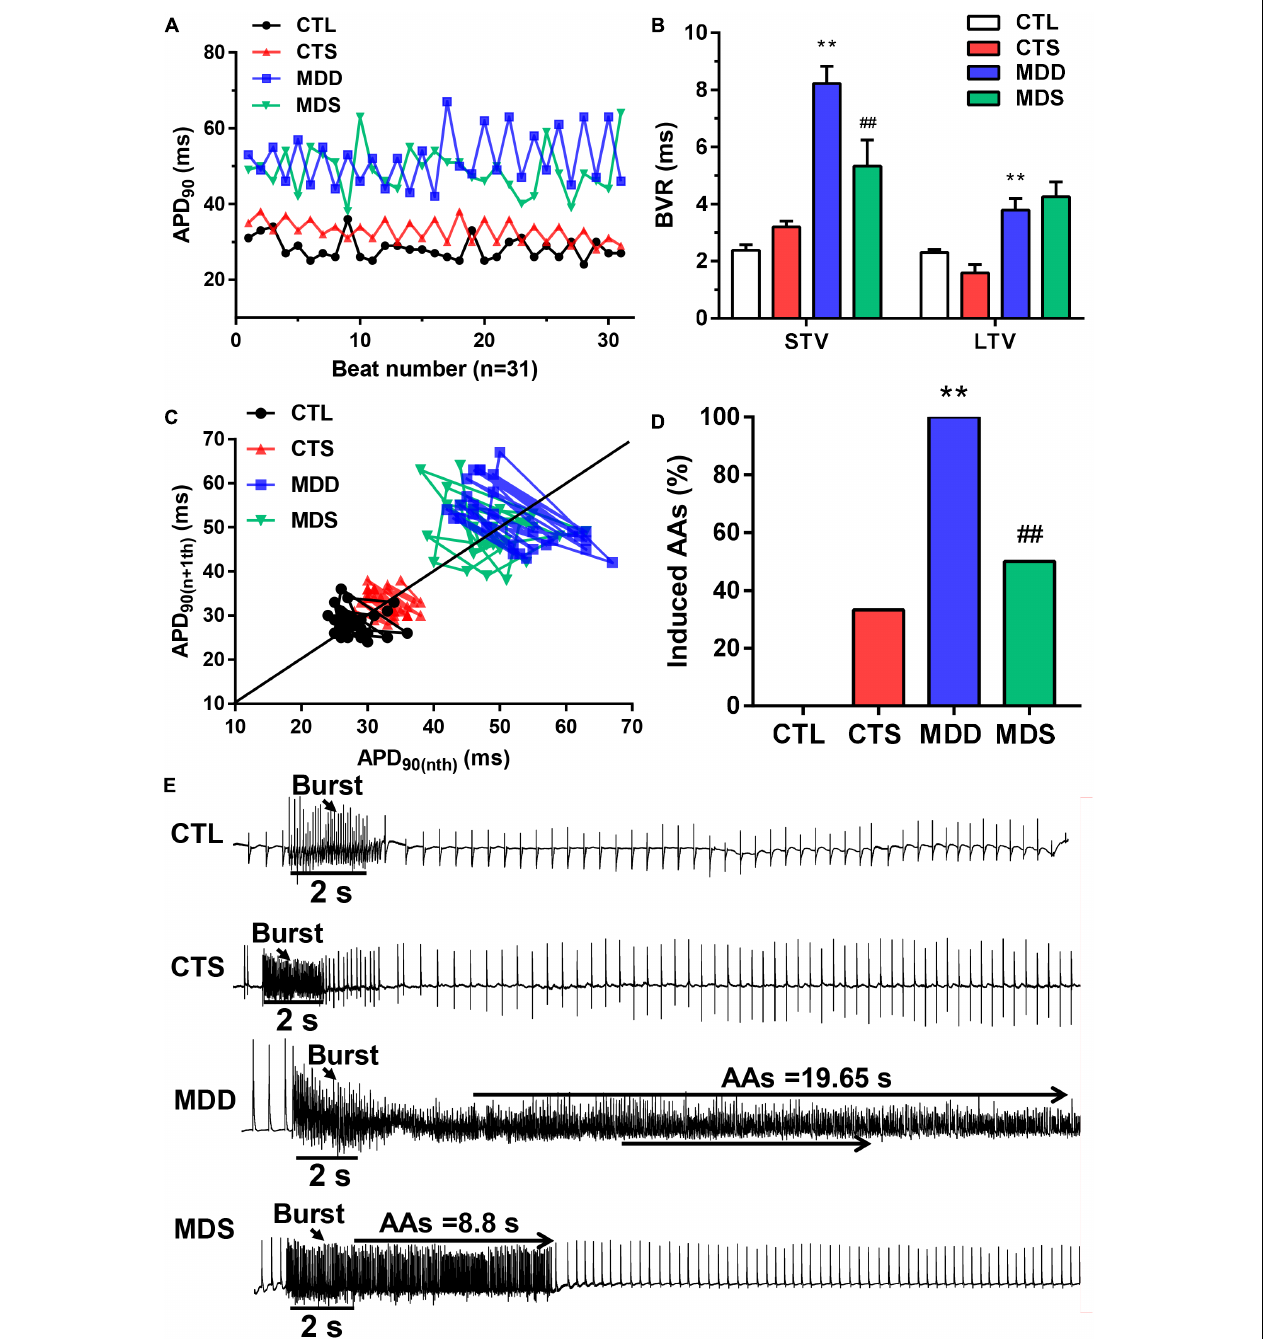
FIGURE 2 | Representative dynamic changes in consecutive 31 APD90 and AA vulnerability. (A) Poincaré plots showed a representative increase in BVR in the MDD group. (B) The mean STV and LTV were larger in the MDD group than in the CTL group. (C) The P value for the MDD group vs. the CTL group. (D) AAs were induced in the MDD group, while AAs were not induced in the CTL group. Three out of six rats were induced in the MDS group. (E) Representative recording of burst pacing in the four groups ( n = 6). ∗∗ P < 0.01 vs. CTL group; ## P < 0.01 vs. MDD group.